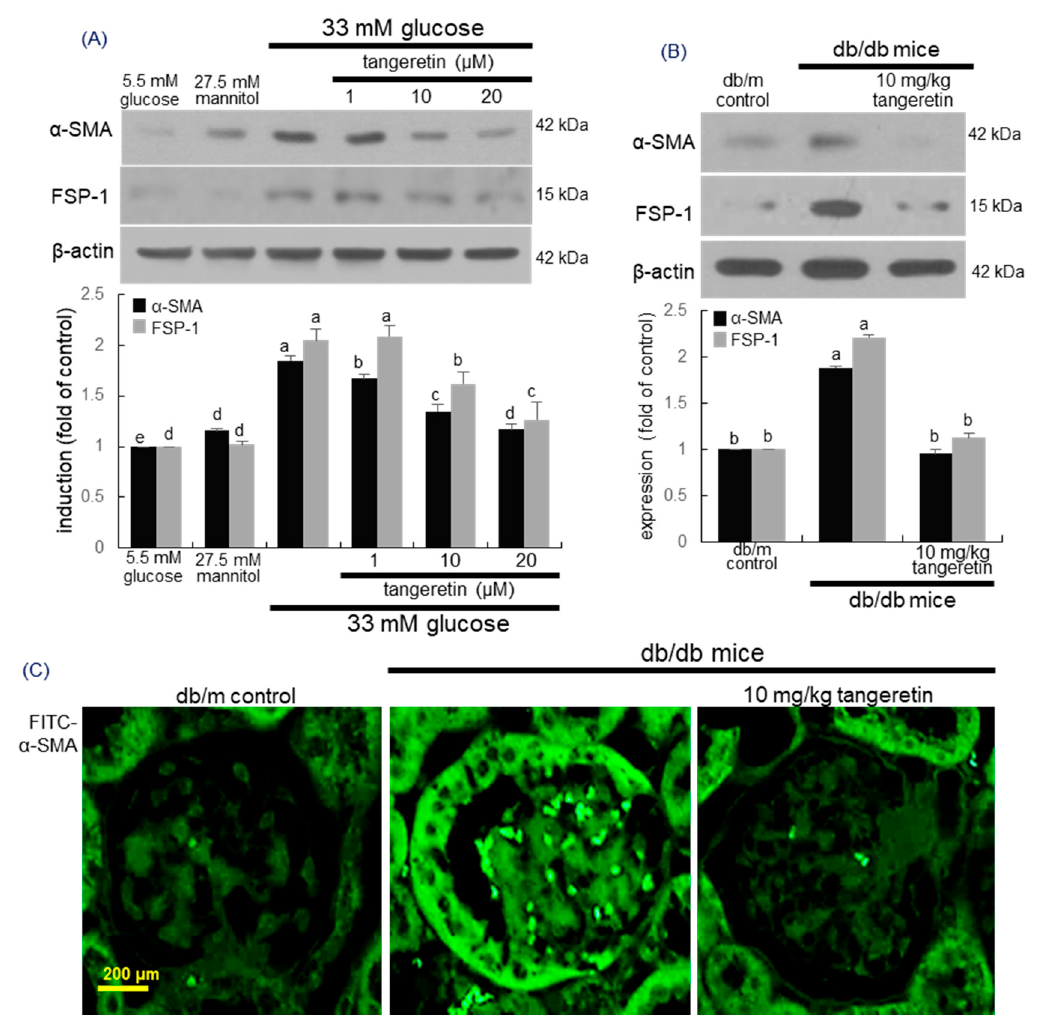
Figure 2. Inhibition of expression of α -SMA and FSP-1 by tangeretin in glucose-exposed podocytes ( A ) and diabetic kidney ( C ). Podocytes were incubated in media containing 5.5 mM glucose, 5.5 mM glucose plus 27.5 mM mannitol as osmotic controls or 33 mM glucose in the absence and presence of 1–20 μ M tangeretin for 4 days ( A ). The db/db mice were orally supplemented with 10 mg/kg tangeretin for 10 weeks ( B , C ). Cell lysates and kidney extracts were electrophoresed on 10%–15% SDS-PAGE and subject to Western blot analysis with a primary antibody against α -SMA and FSP-1 ( A , C ). β -Actin antibody was used as an internal control. The bar graphs (mean ± SEM, n = 3) represent quantitative results of blot bands obtained from a densitometer. Respective values not sharing a letter are different at p < 0.05. Immunohistochemical staining showing glomerular tissue levels of α -SMA of diabetic mouse kidney ( C ). The α -SMA of mouse kidneys was confirmed by FITC-green staining. Each photograph is representative of four mice. Scale bar = 200 μ m.